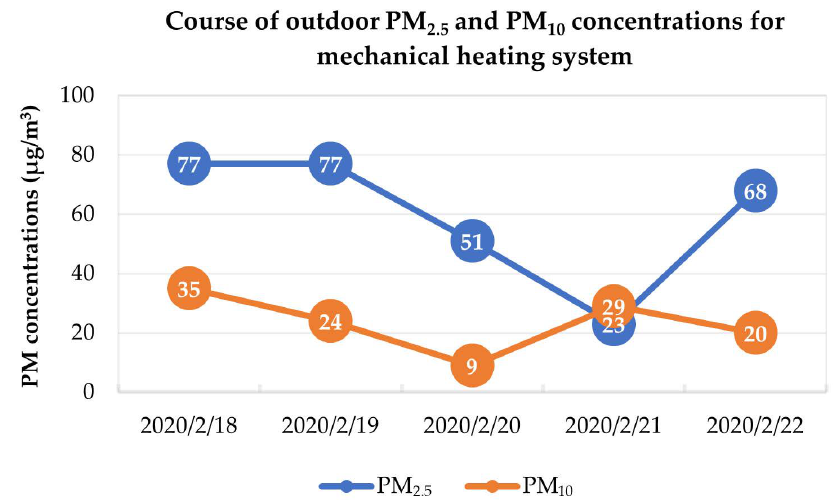
Figure 15. Courses of outdoor PM 2.5 and PM 10 concentrations for MHS [33].